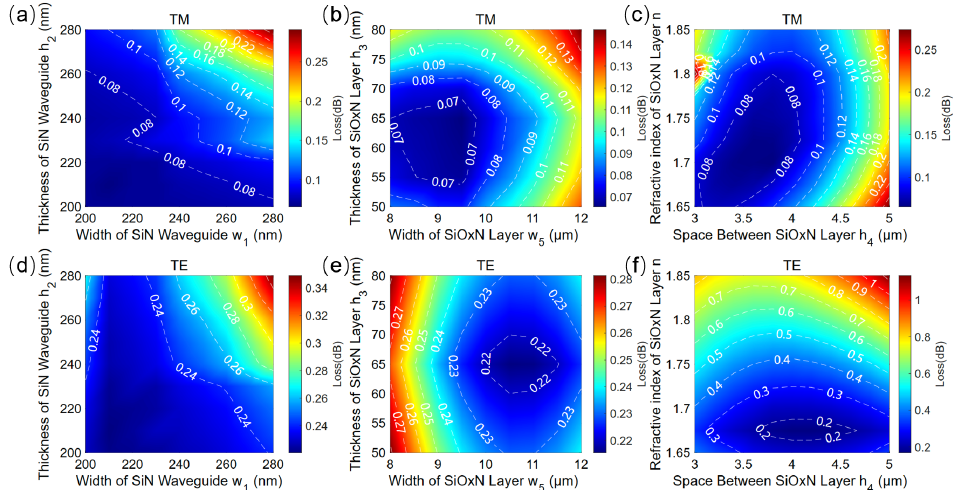
Figure 3. ( a ) Coupling loss change with w 1 and h 2 when w 5 = 9.5 μm, h 3 = 65 nm, h 4 = 3.8 μm, and